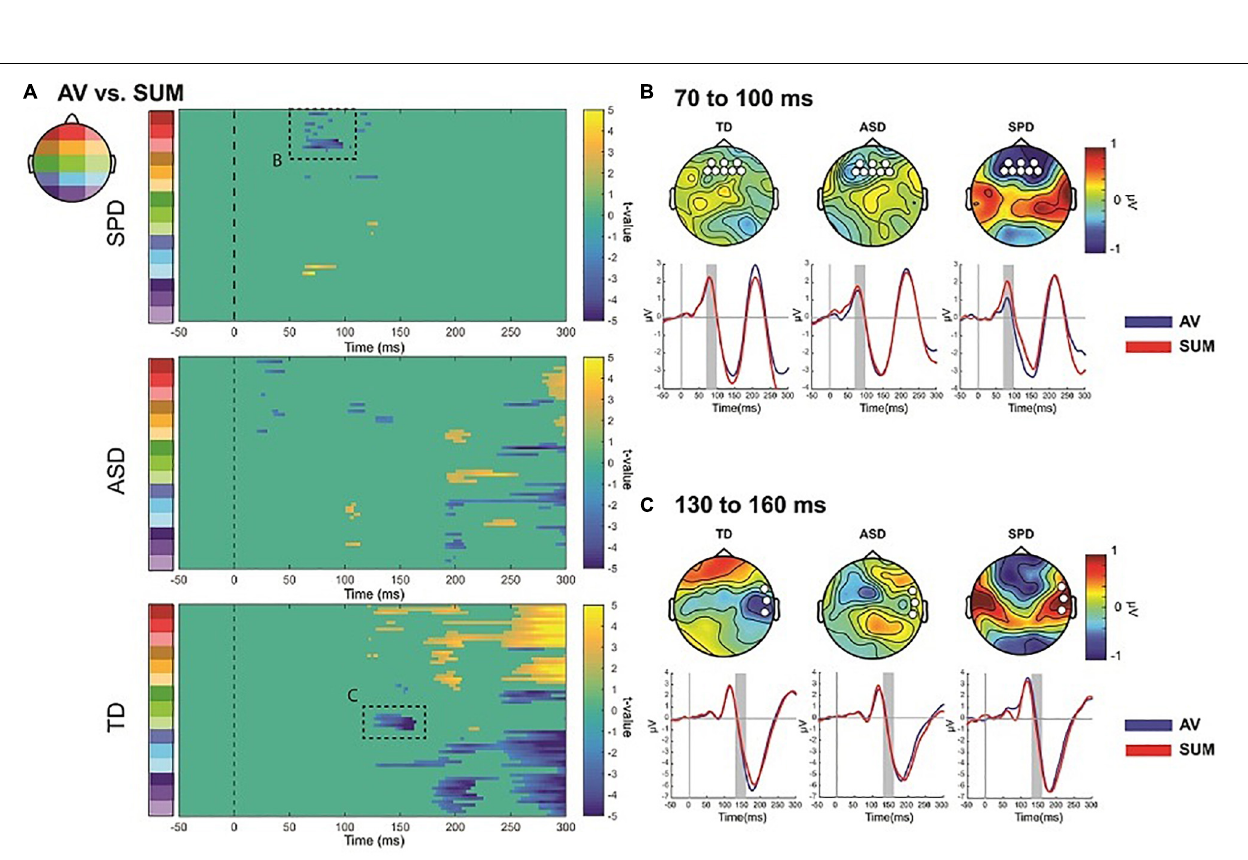
FIGURE 7 | AV versus Sum SCPs, and illustration of follow-up post hoc effects. (A) Statistical cluster plots comparing AV to SUM conditions for each of the three diagnostic groups. Dashed boxes represent effects that were followed up in post hoc ANOVAs across the groups. The letters next to the dashed boxes correspond to the right side panels (B,C) . (B) Illustration of the 70–90 ms period of interest. Topographies are difference topographies (AV minus SUM). The waveforms are the AV and SUM waveforms averaged over the electrodes indicated by the white circles on the corresponding topographies. The time-period of interest is indicated by the gray shaded rectangles. The red trace represents the sum response and the blue trace the multisensory response. (C) Illustration of the 130–160 ms effect. Conventions are the same as those in panel (B) .